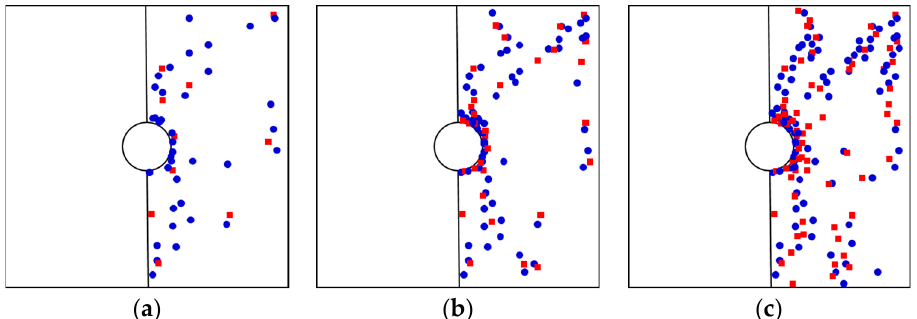
Figure 6. Spatial distribution of micro -cracks with an increase of stress. ( a ) 20% of tress; ( b ) 60% of stress; ( c ) 100% of stress.